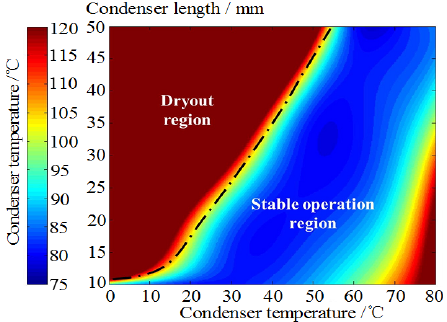
Figure 12. Temperature of condensation section and evaporation section under 18 W heating power [116]. Kim et al, (2018) (The dotted line is the dividing line of dryout region and stable operation region).